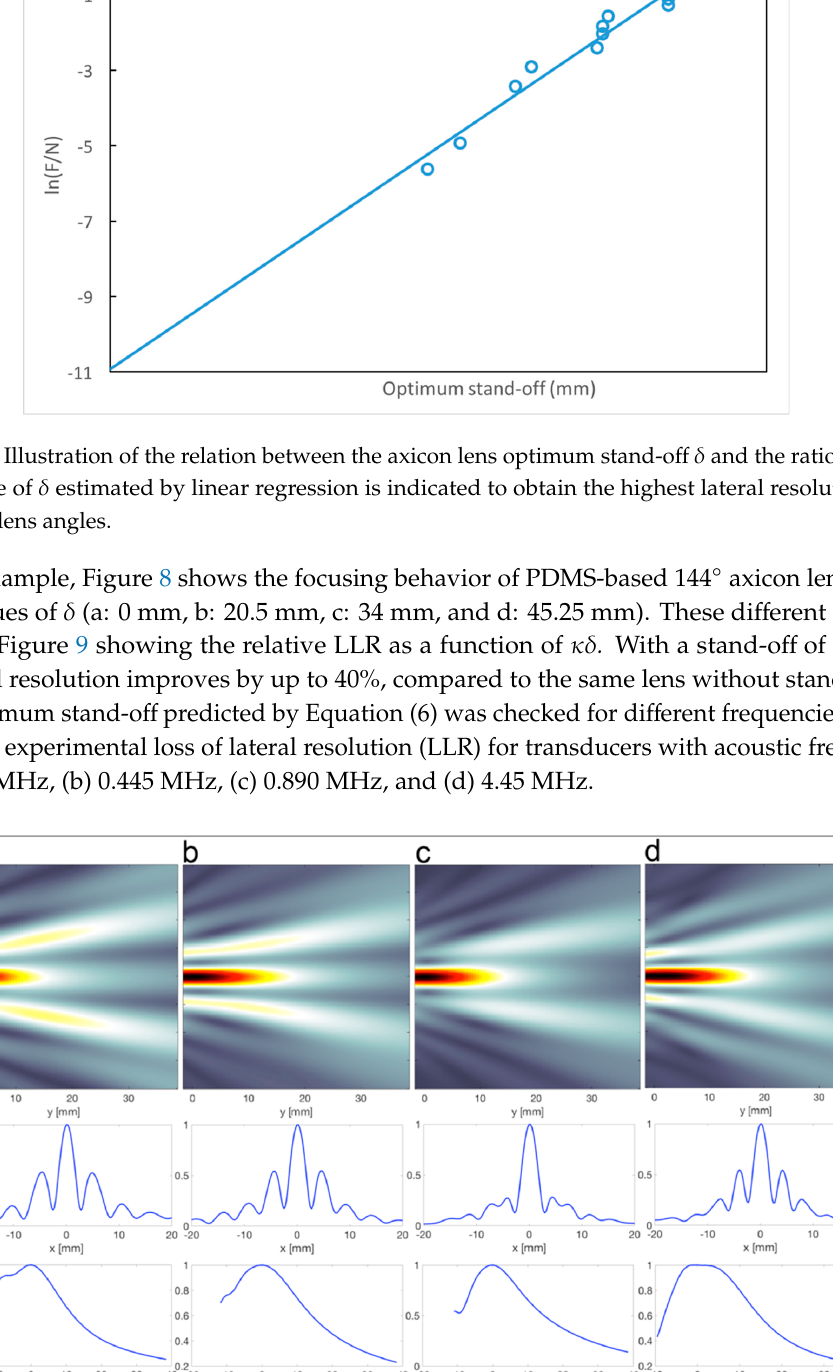
Figure 8. 445 kHz-Cigar-shaped acoustic focus for different settings of the stand-off. ( a ) δ = 0 mm; ( b ) δ = 20.5 mm; ( c ) δ = 34 mm; ( d ) δ = 45.25 mm. (Top) Focusing behavior of the PDMS-based 144° axicon lens with four different values of δ . (Middle) Normalized pressure amplitudes of the lateral beam profile. (Bottom) Normalized pressure amplitudes of the axial beam profile, 0 mm indicates the focus.